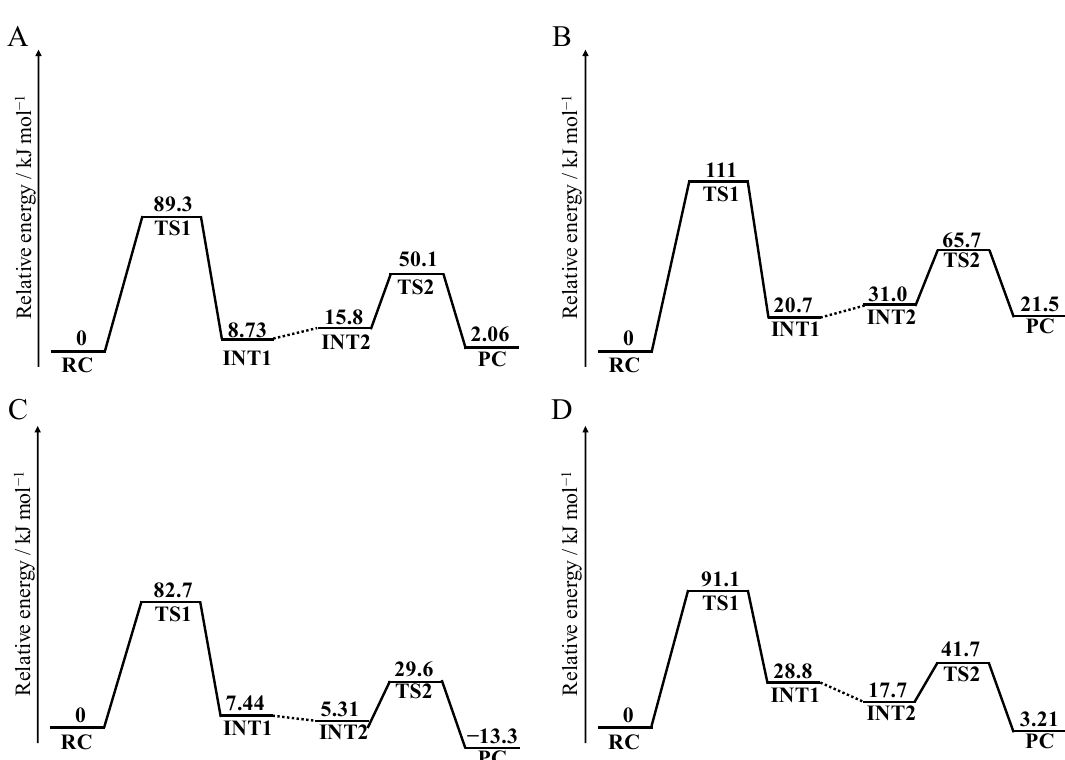
Figure 12. Relative energy profiles of the phosphate- and carbonate-catalyzed reaction calculated using the MP2 / 6-311 + G(2d,2p) // B3LYP / 6-31 + G(d,p) level. Entire energy profiles of ( A ) syn conformation in the phosphate-catalyzed reaction, ( B ) anti conformation in the phosphate-catalyzed reaction, ( C ) syn conformation in the carbonate-catalyzed reaction, and ( D ) anti conformation in the carbonate-catalyzed reaction are shown.